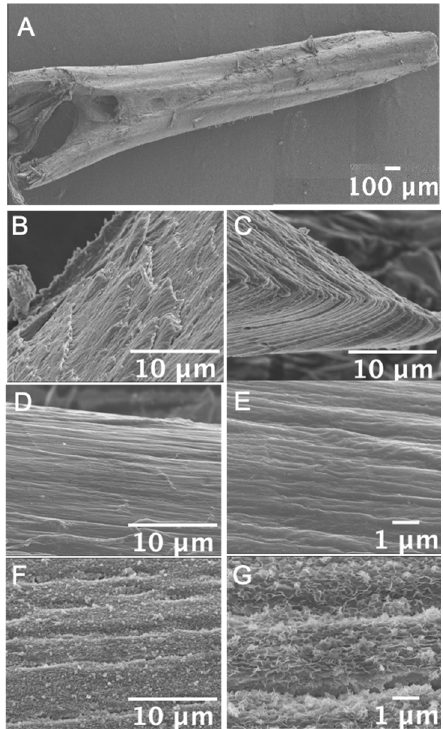
Figure 3. Microstructure of Carassius langsdorfii bone rib. ( A ) Low magnified SEM image of fish rib tip. Each rib shows a flat shape. ( B , C ) The lamellar collagen fiber layers stacked to form this flat shape. ( D , E ) SEM images of rib bone organic surface treated with ethylenediaminetetraacetic acid (EDTA). Collagen bundles were oriented identically to the long axis of rib bone. ( F , G ) SEM images of rib bone inorganic surface treated with NaClO. Small inorganic crystals were aligned identically to the organic orientations.